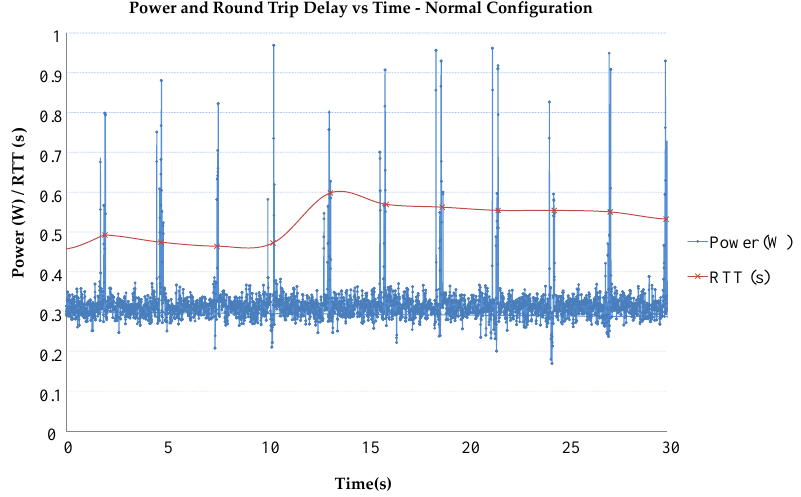
Figure 10. Power and round trip time in normal